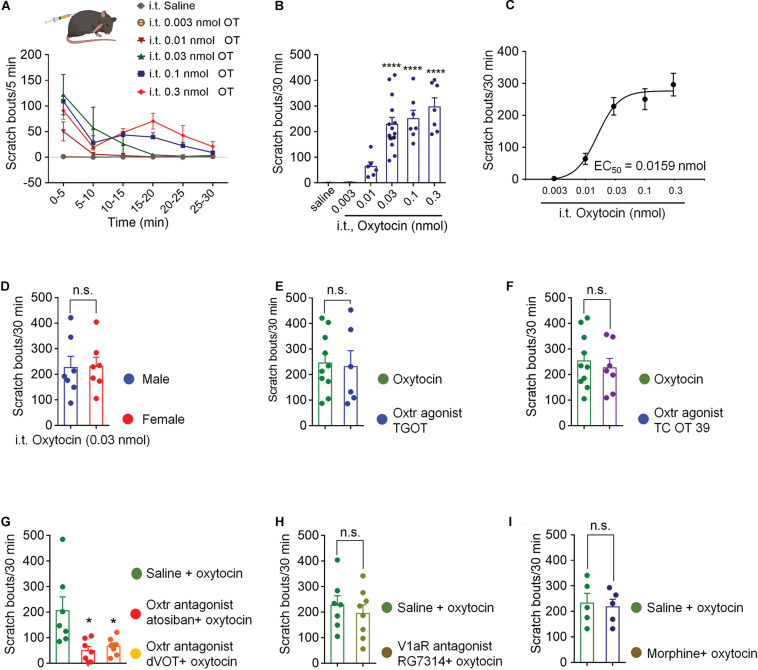
Intrathecal OT induced hindpaw scratching behavior was mediated by spinal OTRs. (A) Time course of different doses of intrathecal OT evoked scratching bouts in mice. OT at dose of 0.003, 0.01, 0.03, 0.1, and 0.3 nmol was administered intrathecally, scratching bouts of the mice were then recorded every 5 min for 30 min. (B) Different doses of intrathecal OT-induced scratching bouts in 30 min after injection. Data are expressed as mean ± SEM. **p < 0.01, ****p < 0.0001 vs. Saline; One-way ANOVA followed by Bonferroni’s post hoc test. (C) Dose-response curve of intrathecal OT-induced scratching behaviors. (D) Intrathecal OT-induced itch behavior in male and female mice. OT at dose of 0.03 nmol was administered intrathecally, scratching bouts was then recorded for 30 min. Data are expressed as mean ± SEM paired T- test. (E) Intrathecal administration of a selective OT receptor agonist, TGOT (0.03 nmol) caused scratching behaviors similar to OT in mice. (F) Intrathecal administration of selective V1aR antagonist, also a selective OT receptor agonist, TC OT 39 (0.1 nmol) caused significant scratching behaviors in mice. (G) Intrathecal administration of selective OT receptor antagonists, Atosiban (0.1 nmol) and dVOT (0.1 nmol) decreased OT induced scratching behaviors in mice. (H) Selective blockade of V1aR by pretreatment of its antagonist, RG7314 (0.1 nmol) did not prevent OT-induced scratching behaviors in mice. I Morphine (0.3 nmol, i.t.) had no effect on OT-induced scratching. Data are expressed as mean ± SEM paired T- test. *p < 0.05.